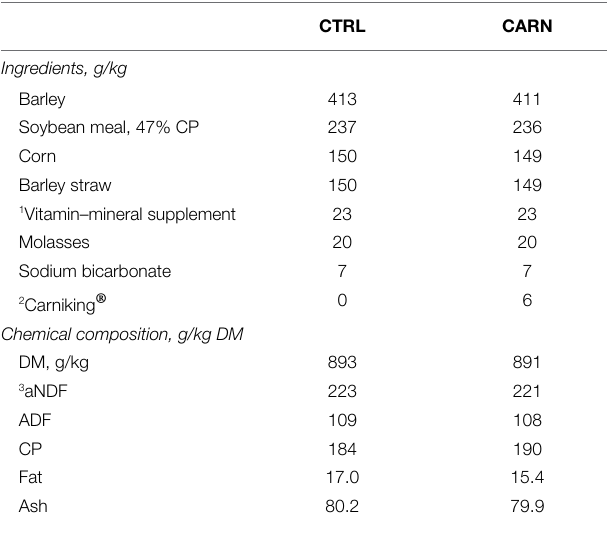
TABLE 1 | Ingredients and chemical composition of the complete pelleted diets (control, CTRL and carnitine, CARN) administered during the fattening period of early feed restricted Assaf